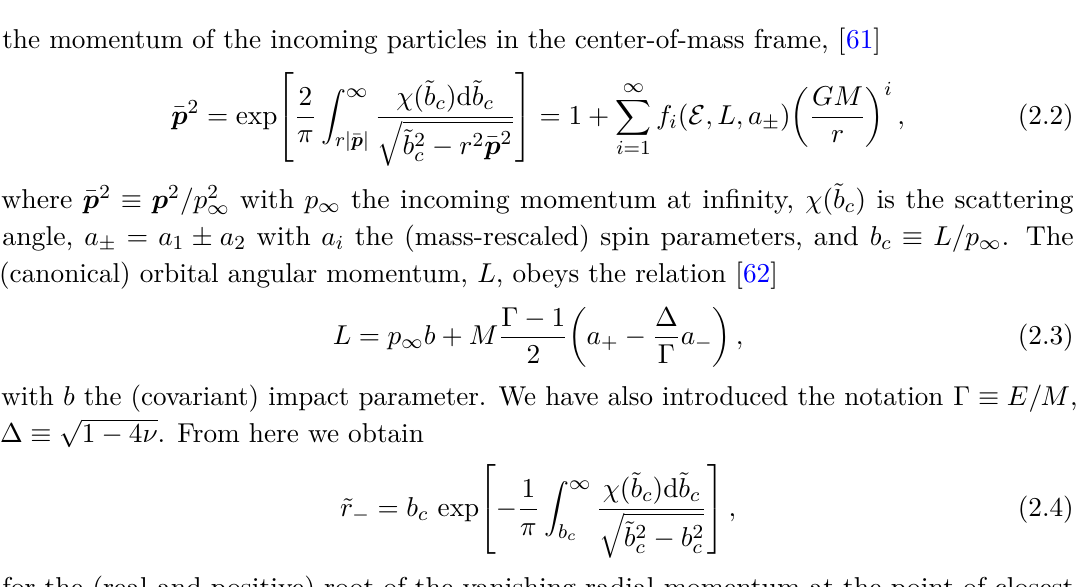
Figure 1 . The geometry for unbound and bound motion. See the text for definition of the various